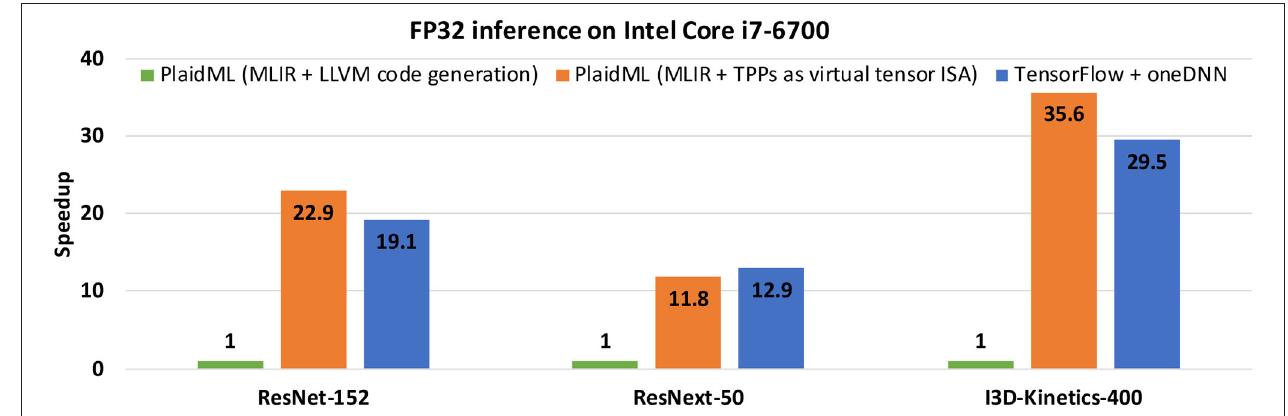
FIGURE 32 | FP32 inference with PlaidML on various workloads: ResNet-152, ResNext-50, and